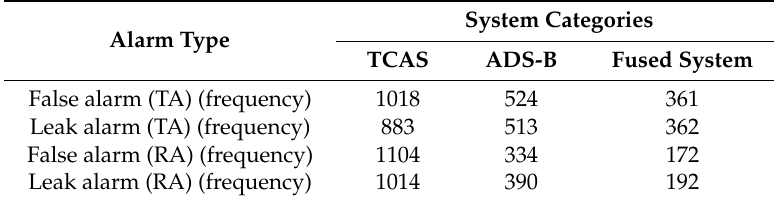
Figure 13. System false alarm and leak alarm statistics graph. Table 2. Statistics of early alarm and hysteresis alarm during ta (35–45 s), ra (<35 s) in 200